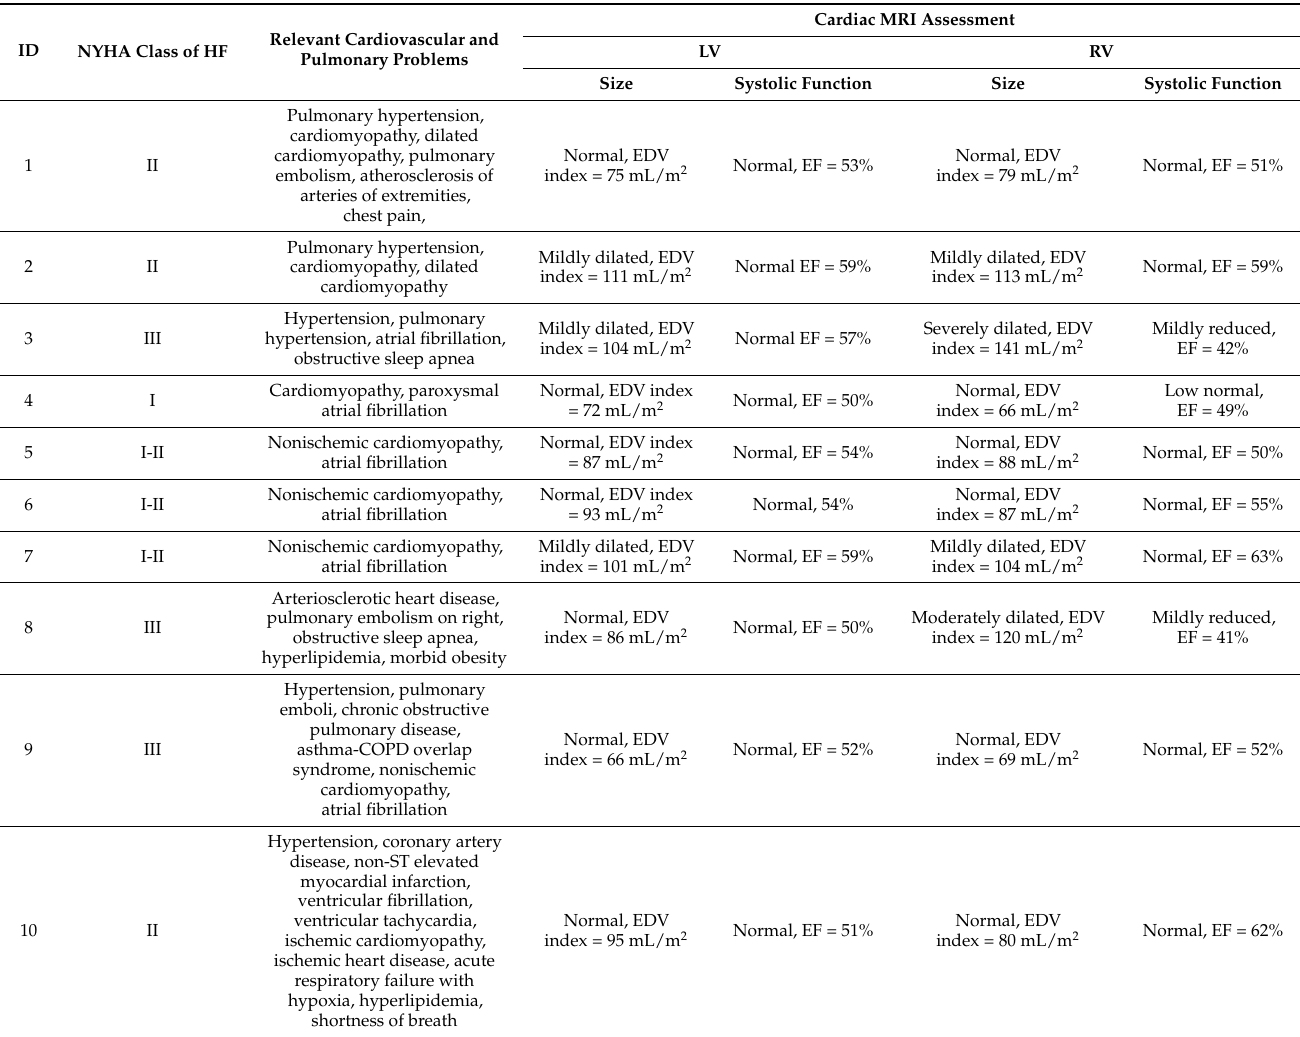
Table 2. NYHA classification, diagnosed diseases and cardiac MRI assessment of the patients with